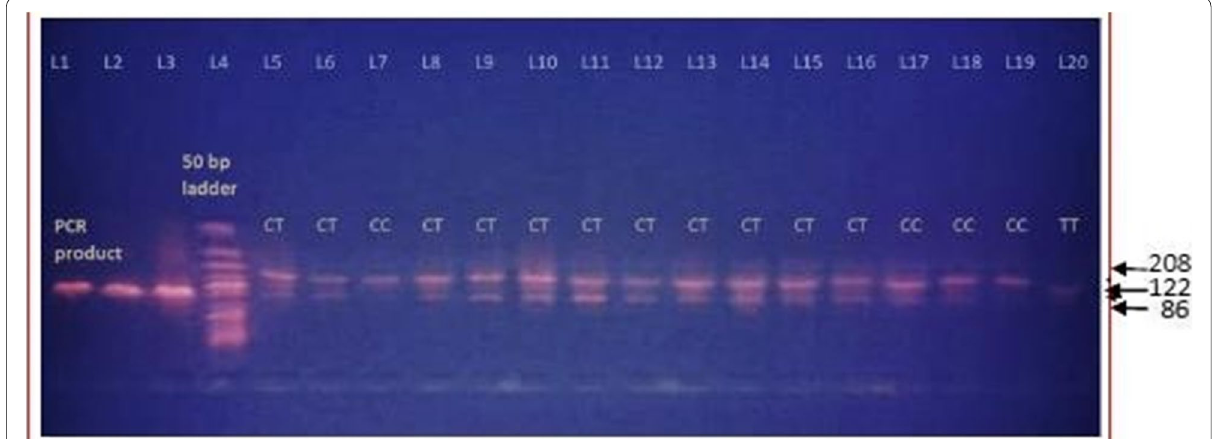
Fig. 1 Lanes 1, 2 and 3 show PCR products. Lane 4 shows a 50 bp DNA ladder; lanes 5, 6, and 8–16 show the heterozygote (CT) cut into fragments of lengths 208 and 122. Lanes 7 and 17–19 show the homozygous (CC) uncut, having a length of 208 bp. Lane 20 shows the homozygous (TT) uncut, having a length of 86 bp (lanes are numbered in the image from left to